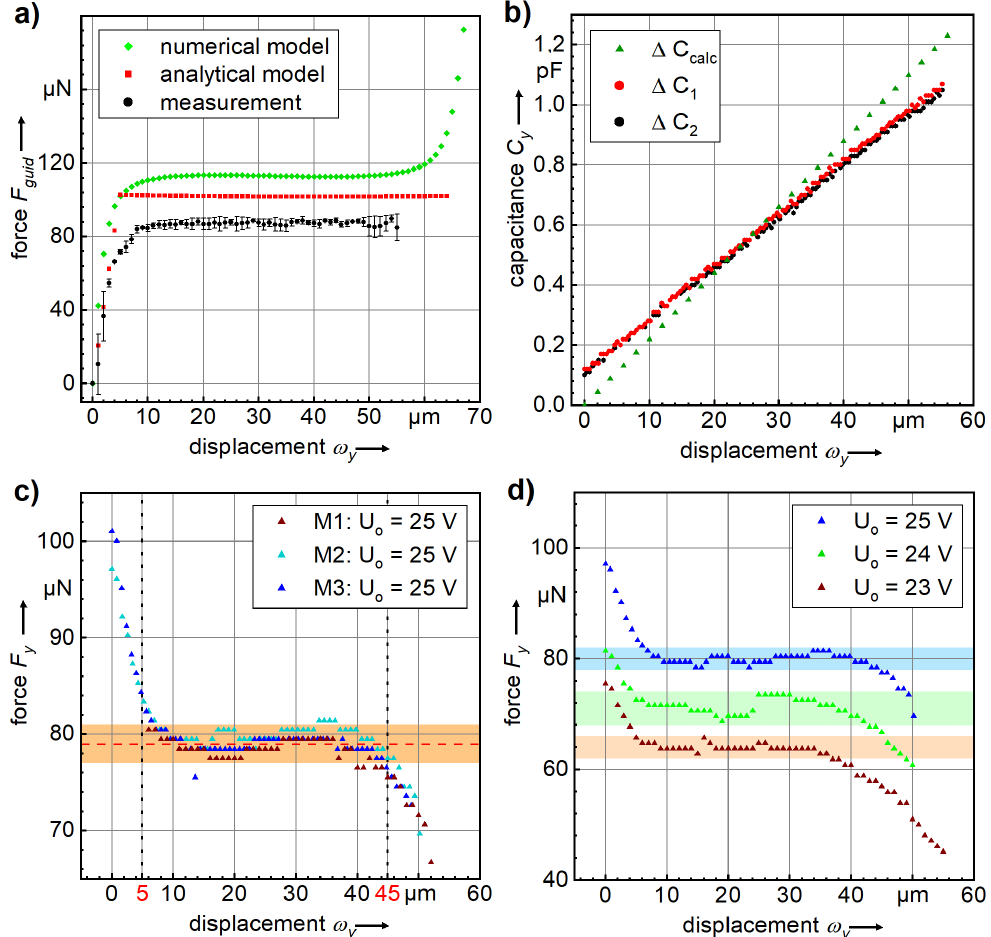
Figure 8. ( a ) Force-displacement characteristic of the non-linear spring system without electrostatic actuation. ( b ) Capacitance-displacement curve measured by the FDC1004Q chip and calculated by Formula(1) with l 0 = 100 µ m, n c + = n c − = 62, g = 4 µ m, and t = 20 µ m. ( c ) Three constant- force measurements with an electrostatic operating voltage U o = 25V with optimized non-linear spring system parameters k s,y ≈ 3 N and b c = 3.5 µ m comparable to Figure 3. ( d ) Constant-force m measurement with different operating voltages. For the analytical model, the following parameters were used: E [ 110 ] = 169GPa, k s,y ≈ 2.47 N , L c = 860 µ m, b c = 3.3 µ m, h ≈ 35 µ m, t = 20 µ m, m